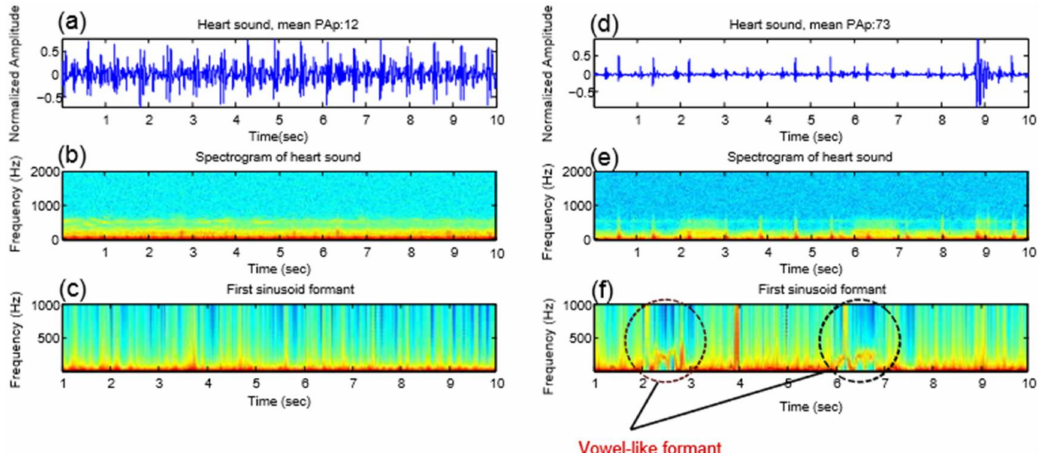
Figure 6. Spectrogram analysis and first formant of ten seconds duration of heart sounds. ( a , d ) Heart sound recording; ( b , e ) spectrogram; ( c , f ) first sinusoid formant using the sine wave replica. At left, a subject with a mean pulmonary artery pressure of 12 mmHg, while at right a subject with a mean pulmonary artery pressure of 73 mmHg. In the bottom panel, there is a clear vowel-like pattern in the frequency distribution representing low entropy in the subject with pulmonary artery hypertension. Abbreviations: PAp = pulmonary artery pressure, sec = second, Hz =